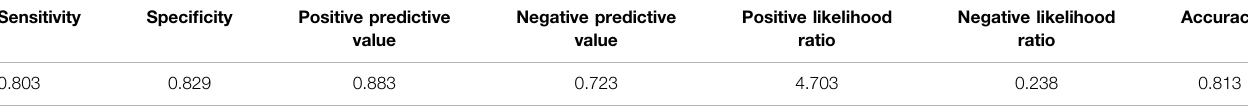
TABLE 3 | The ability of eGFR (cut off 160 ml/min/1.73 m 2 ) to classify and distinguish antibiotic prolongation.